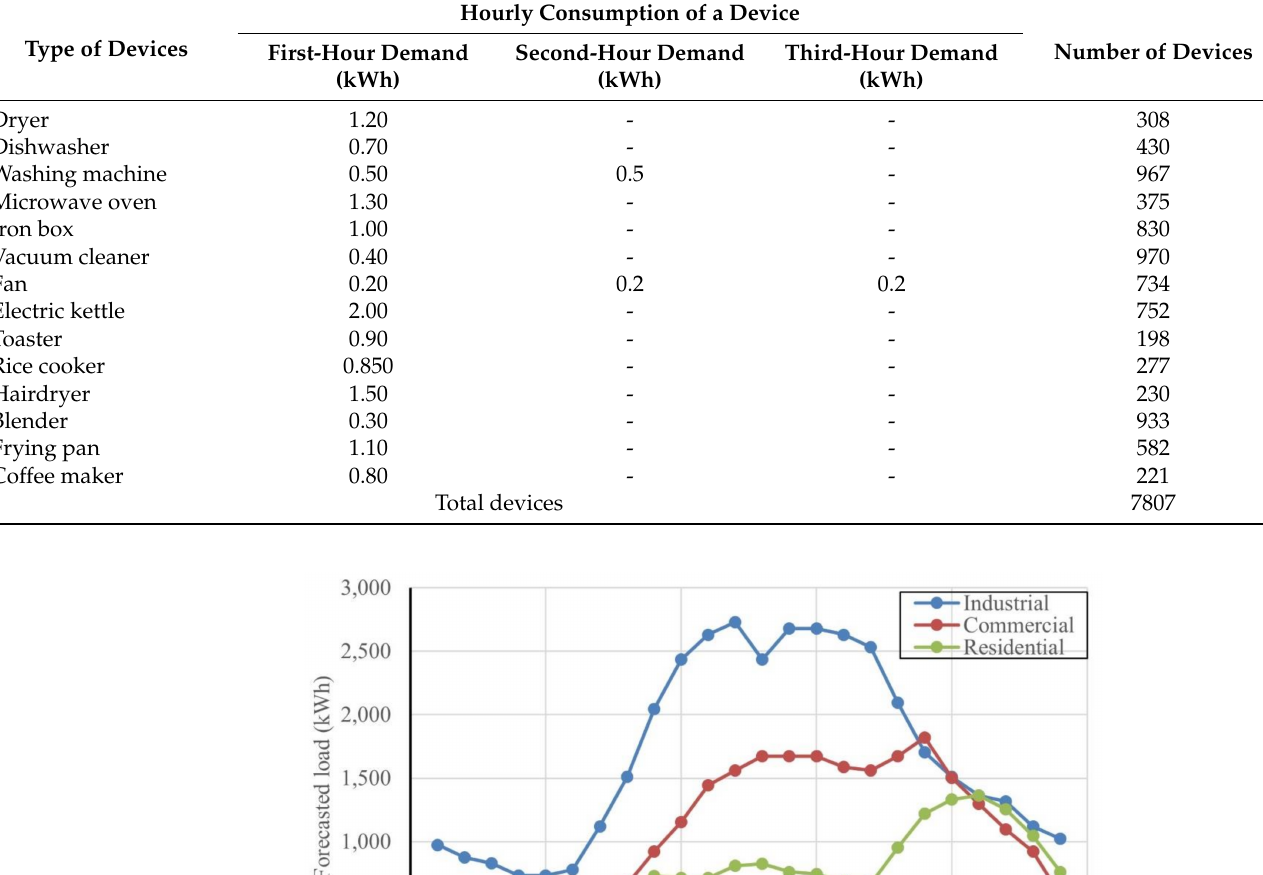
Table 5. Controllable loads present in the residential area.